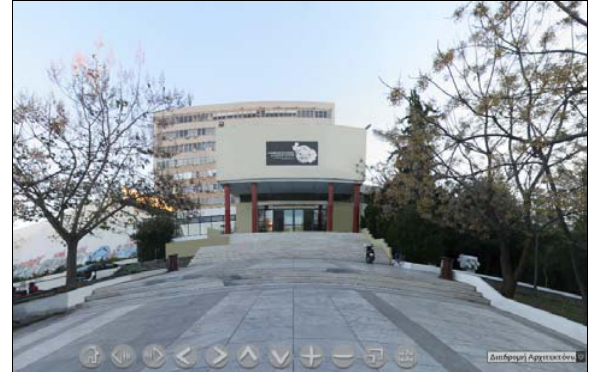
Figure 13. The starting interface.